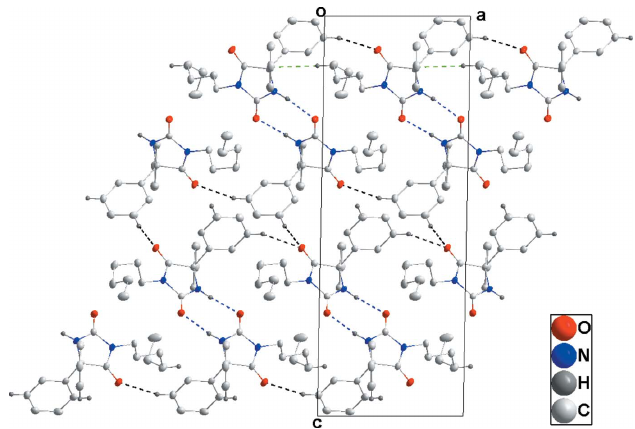
Figure 3 Packing viewed along the b -axis direction with intermolecular inter- actions depicted as in Fig. 2.